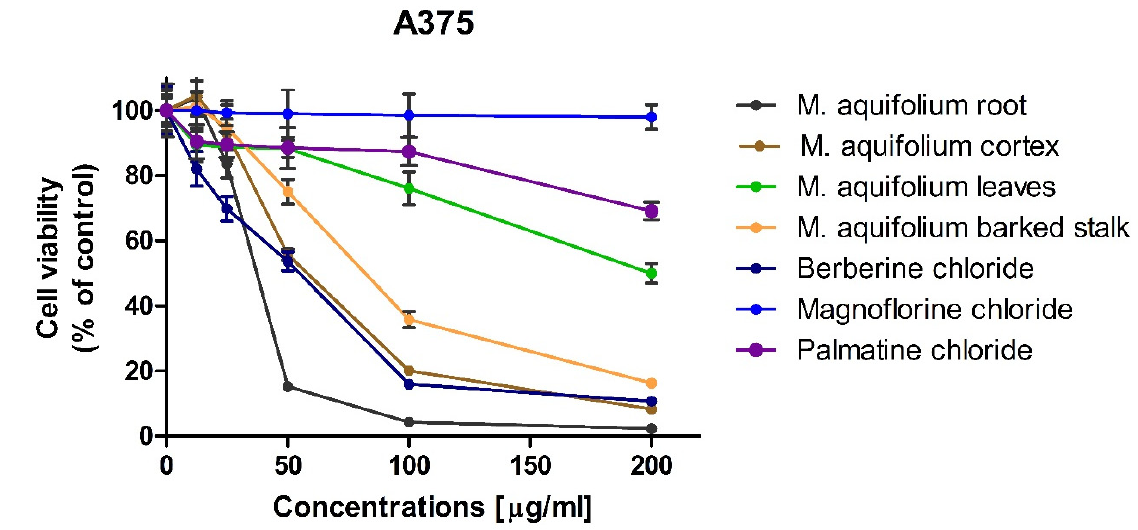
Figure 8. Effect of alkaloid standards and Mahonia aquifolium extracts on the viability of human melanoma A375 cells.